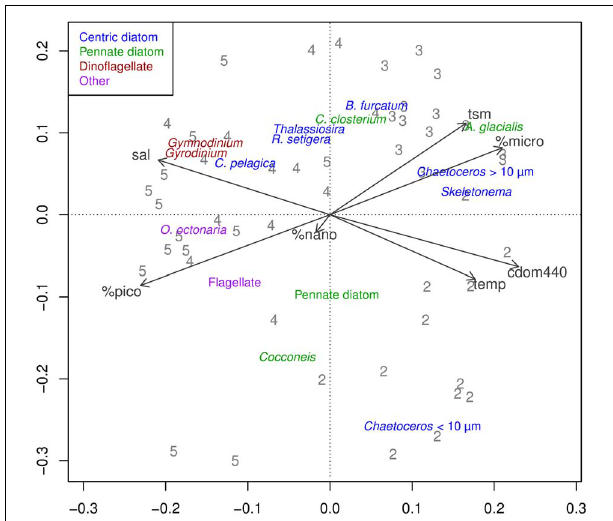
FIGURE 10 | Principal components analysis of phytoplankton species by trip. PCA sample scores are plotted as trip numbers. Species scores are plotted as species names. The arrows indicate environment